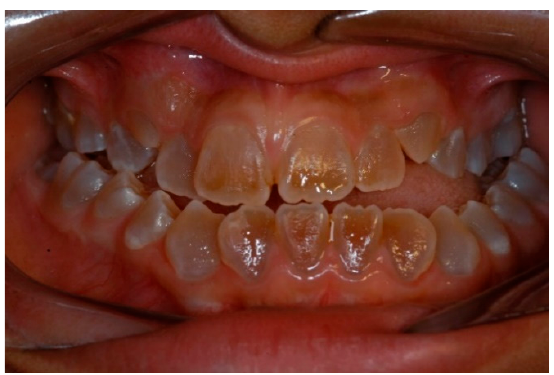
Figure 3. Malocclusion in OI type III patient and dentinogenesis imperfecta.